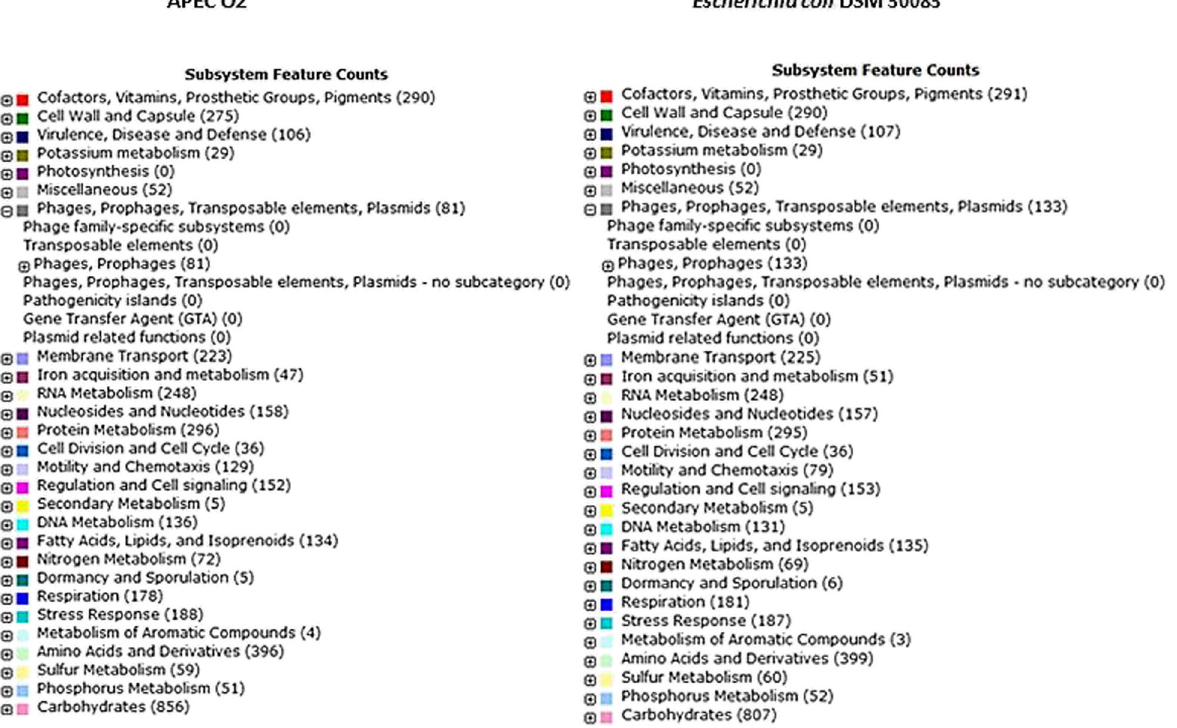
Fig. 5 Subsystem feature counts in APEC_O2 and E. coli DMS 30083